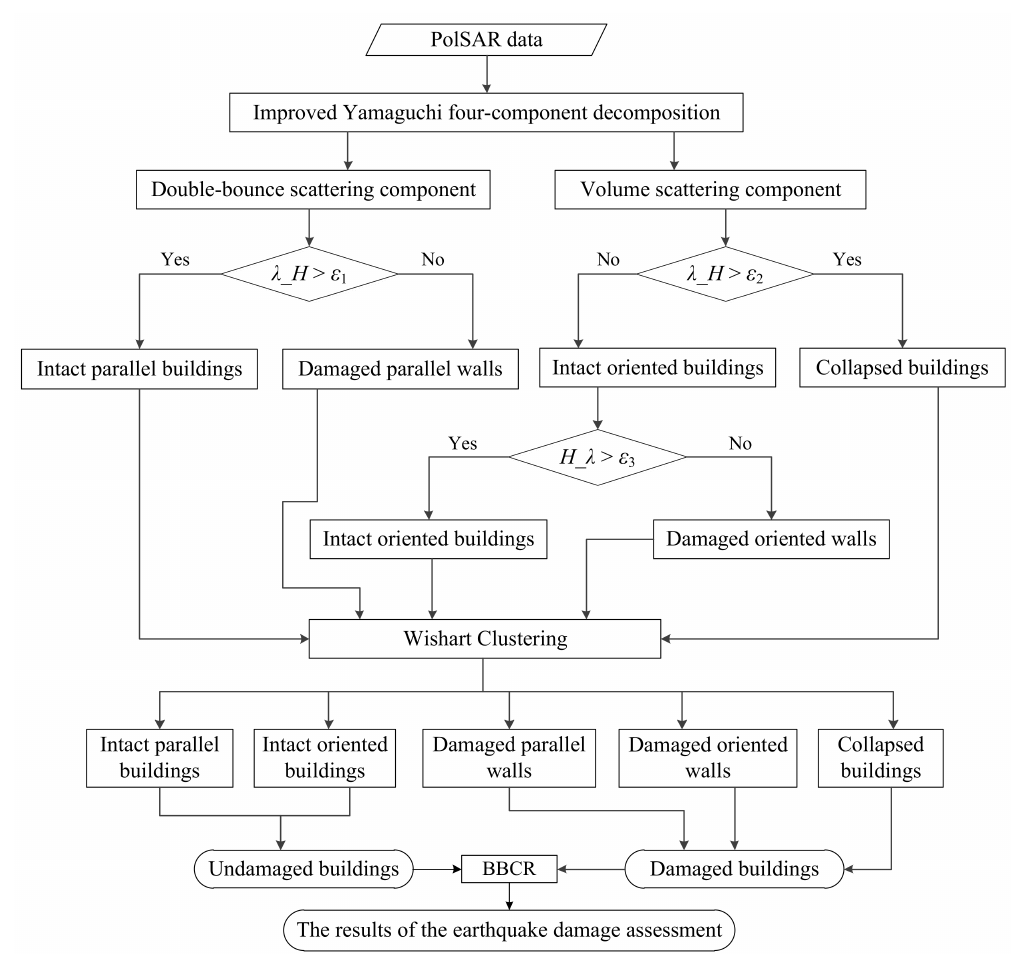
Figure 1. The process flow diagram of the damage estimation